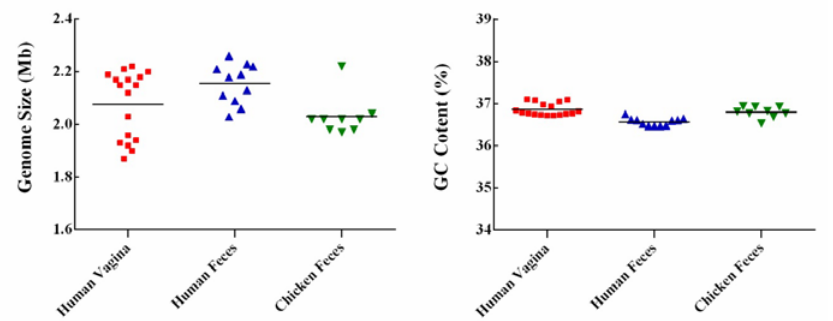
Figure 1. Genome size and GC content of L. crispatus . The red square, blue triangle, and green inverted triangle represent L. crispatus isolated from the human vagina, human feces, and chicken feces, respectively.